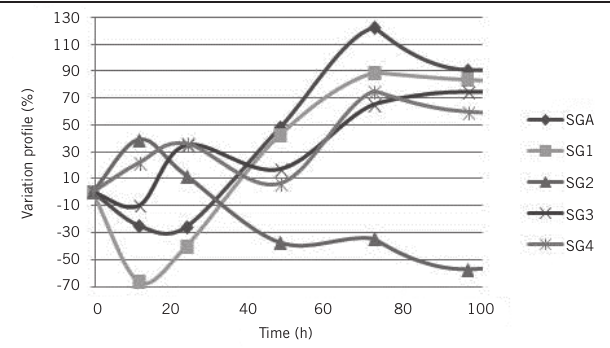
figurE 7 − Time kinetics of protein expression variation in electrophoresis, contrasted to control, of the main blood proteins of molecular weight greater than and equal to that of albumin, in a period of 12 h to 96 h SGA: subgroup albumin; SG1: subgroup 1; SG2: subgroup 2; SG3: subgroup 3; SG4: subgroup